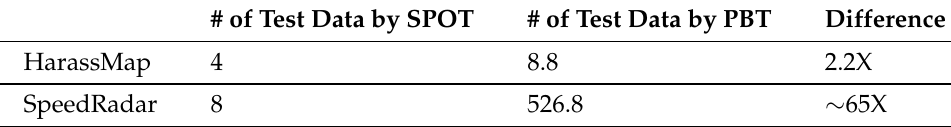
Table 2. The minimum test data required to cover 100% JDU path coverage. # of Test Data by SPOT # of Test Data by